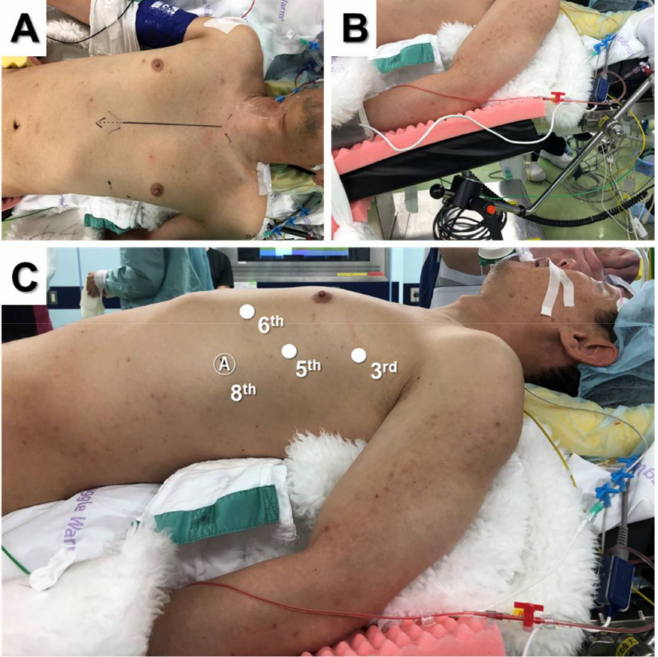
Figure 1. Supine position for three-arm robotic thymectomy using the lateral approach ( A ). The ipsilateral forearm was fixed at a lower position than the bed ( B ). Port placement ( C